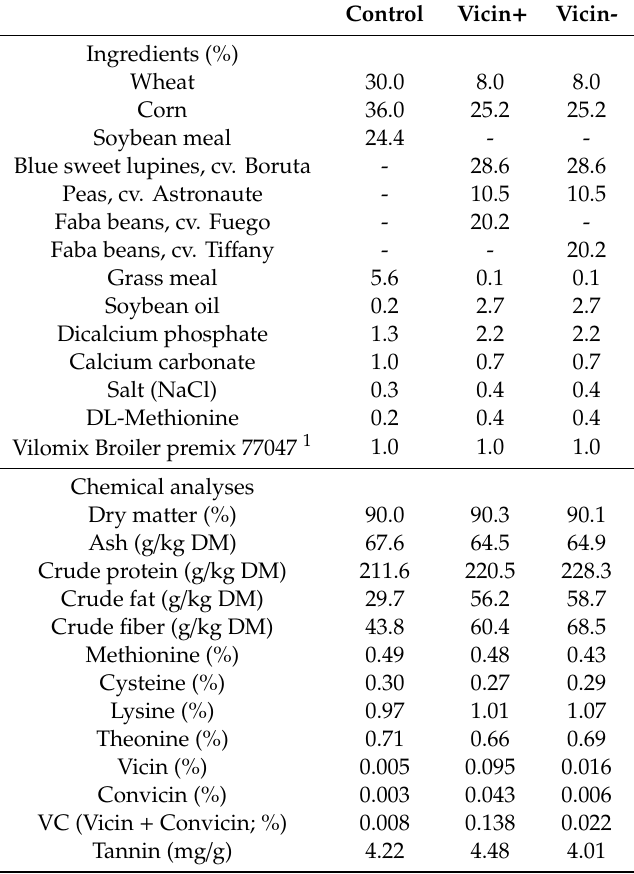
Table 1. Ingredient composition of each experimental